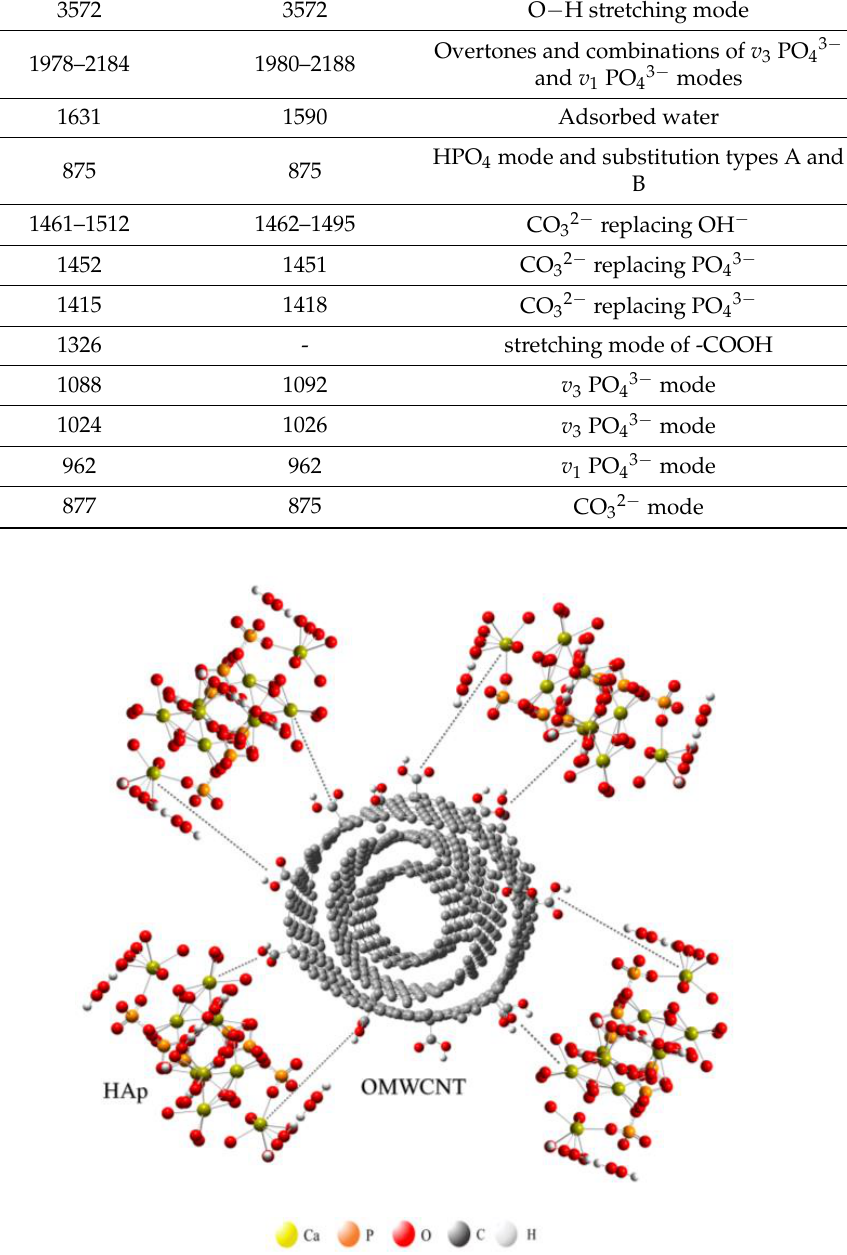
Figure 4. FTIR spectrum of the HAp (a) , HAp/OMWCNT (b) , and HAp/MWCNT (c) samples.